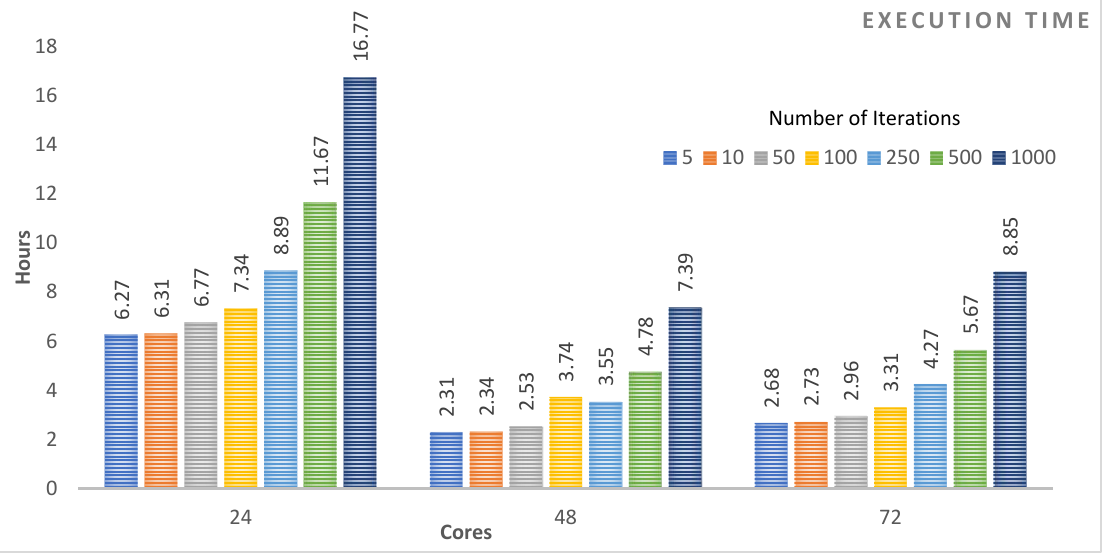
Figure 17. Execution time vs. number of cores for various numbers of LDA iterations (a limited number of features— 10,000 keywords).